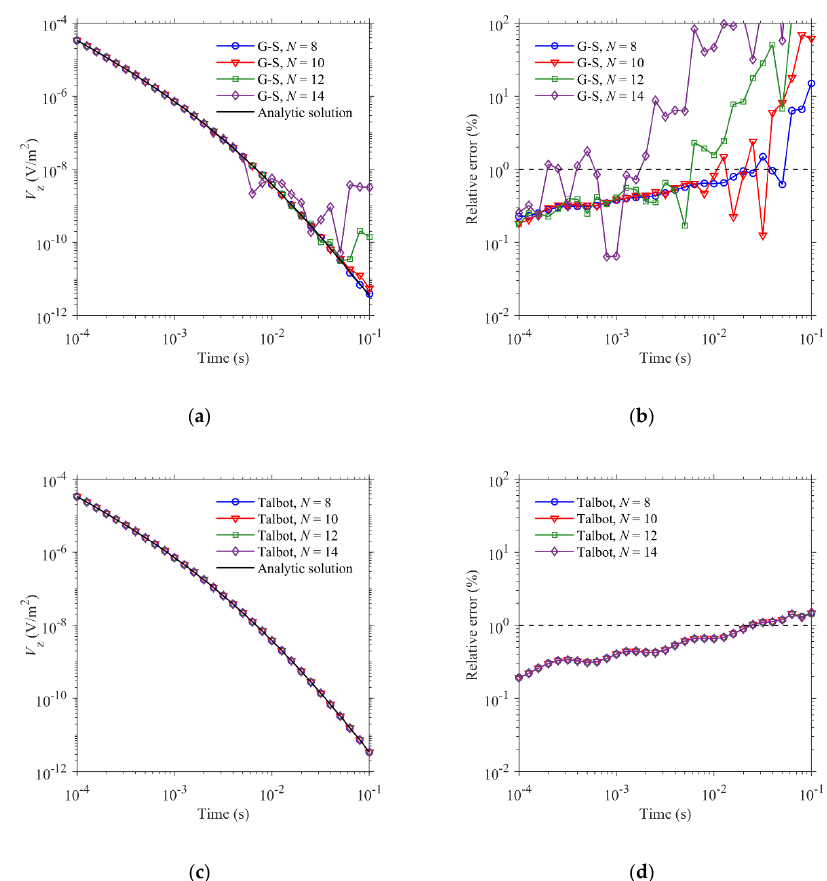
Figure 2. Numerical results of a trapezoidal wave source for homogeneous sea half-space. ( a ) Voltage response of the G-S algorithm; ( b ) errors of the G-S algorithm relative to the analytic solution, where the dashed line indicates a relative error of 1%; ( c ) voltage response of the Talbot algorithm; ( d ) errors of the Talbot algorithm relative to the analytic solution, where the dashed line indicates a relative error of 1%.